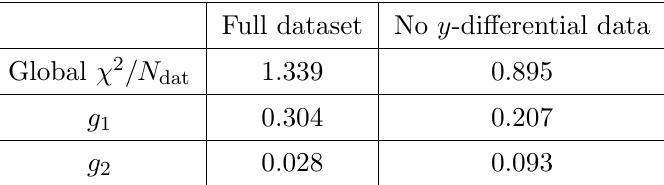
Table 7 . The values of the global (cid:31) 2 normalised to the number of data points N dat from the (cid:12)t to the full dataset and to a reduced dataset without the y -di(cid:11)erential ATLAS datasets, both using the parameterisation in eq. (4.2). For completeness, we also report the best-(cid:12)t values of the parameters g 1 and g 2